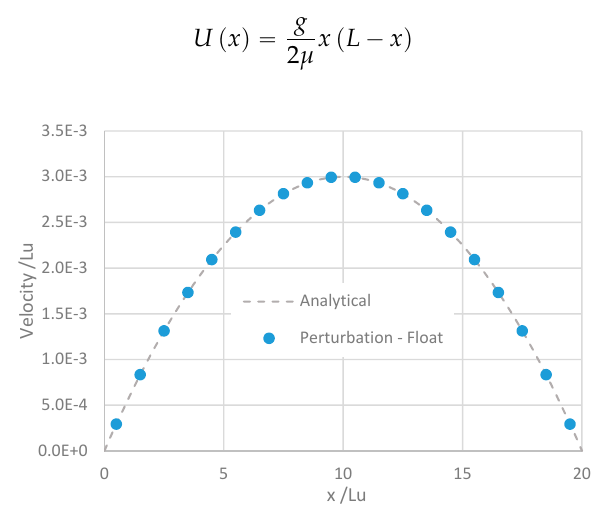
Figure 2. Poiseuille flow between two plates separated by 20 lattice units (Lu).